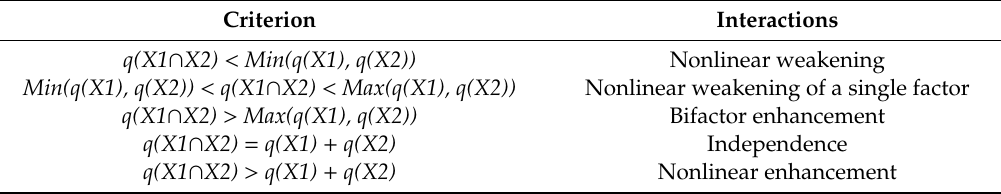
Table 2. Categories of interactions between two